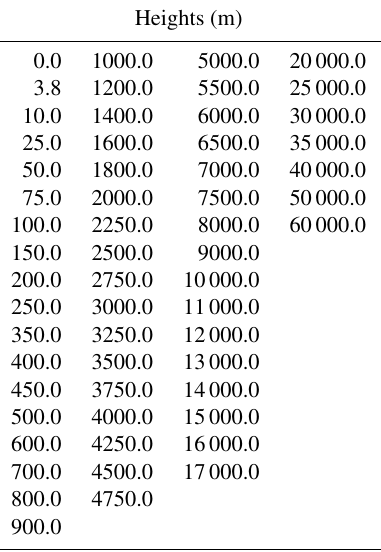
Table 6. The vertical grid to which all gas profiles (H 2 O, CO 2 , O 3 , N 2 O, CO, CH 4 , and O 2 ) were interpolated before being used as input to the Rapid Radiative Transfer Model (RRTMv3.3). Note that the second point (3.8m) is at the same height as the surface